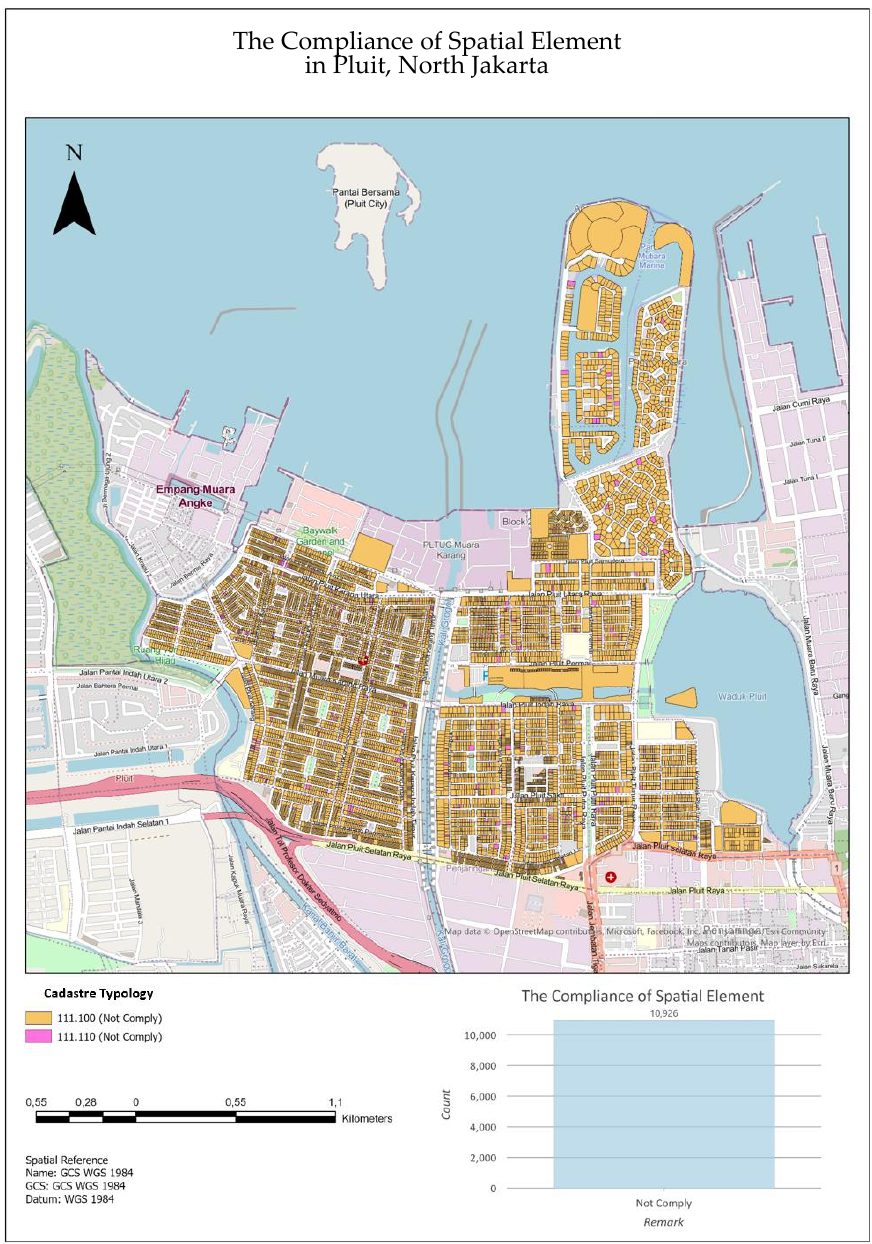
Figure A1. The compliance of spatial element in Pluit Ward (map background: Open- streetmap).